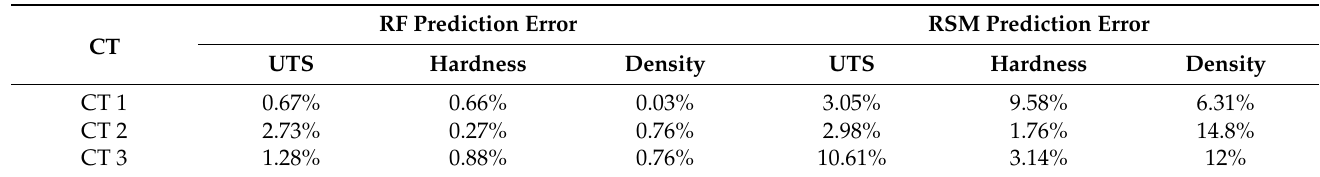
Table 13. Random Forest and RSM Prediction Error.